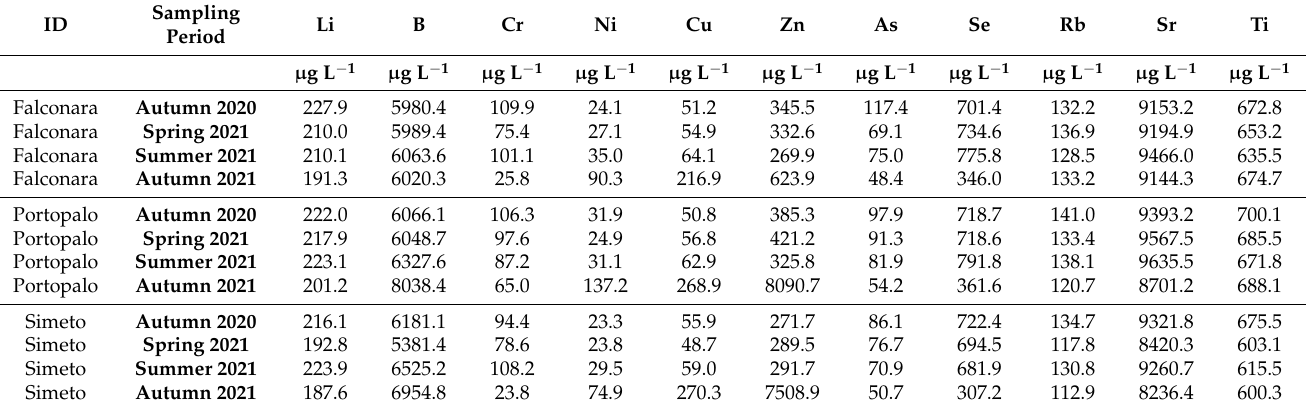
Table 4. Concentrations of trace chemical components of seawater sampled at the Falconara, Portopalo, and Simeto sites. Each seasonal value represents the average of the two samples that were